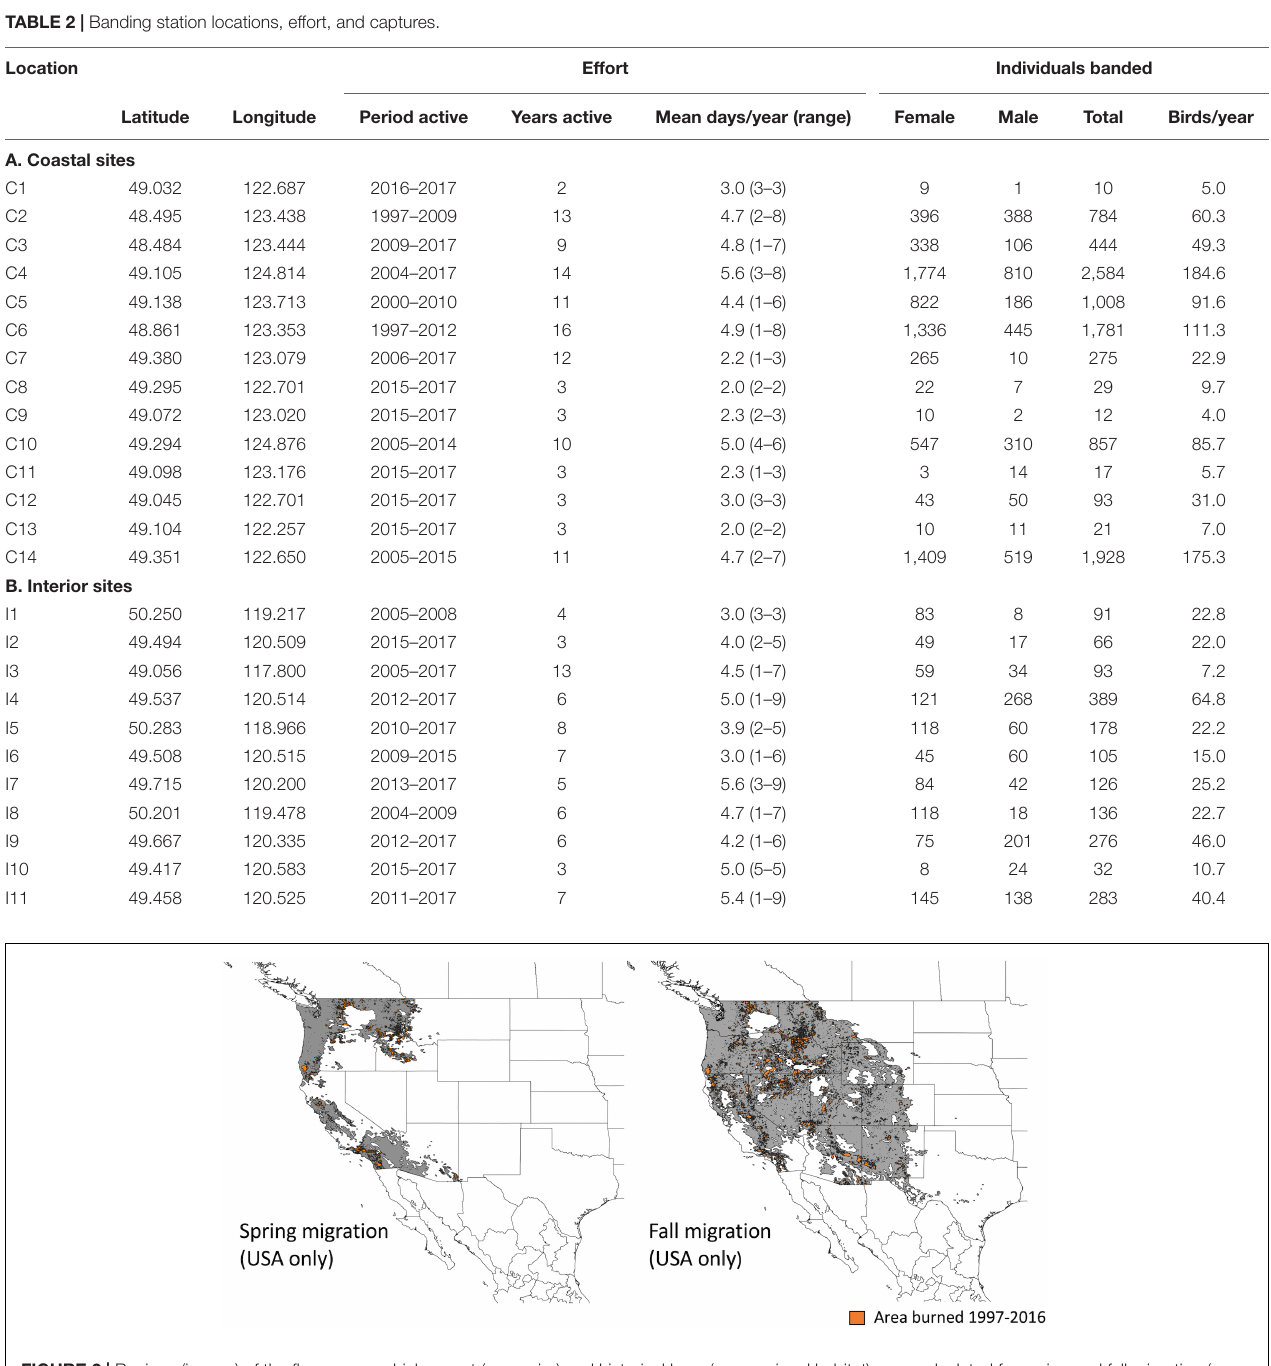
FIGURE 2 | Regions (in gray) of the flyway over which recent (year-prior) and historical burn (successional habitat) were calculated for spring and fall migration (see Figure 3A ). These regions were defined using smoothed eBird range maps; Mexico was excluded due to lack of fire data. Areas highlighted in orange illustrate the locations of all wildfires that contributed to our “recent burn” metric (i.e., areas that burned between 1997 and